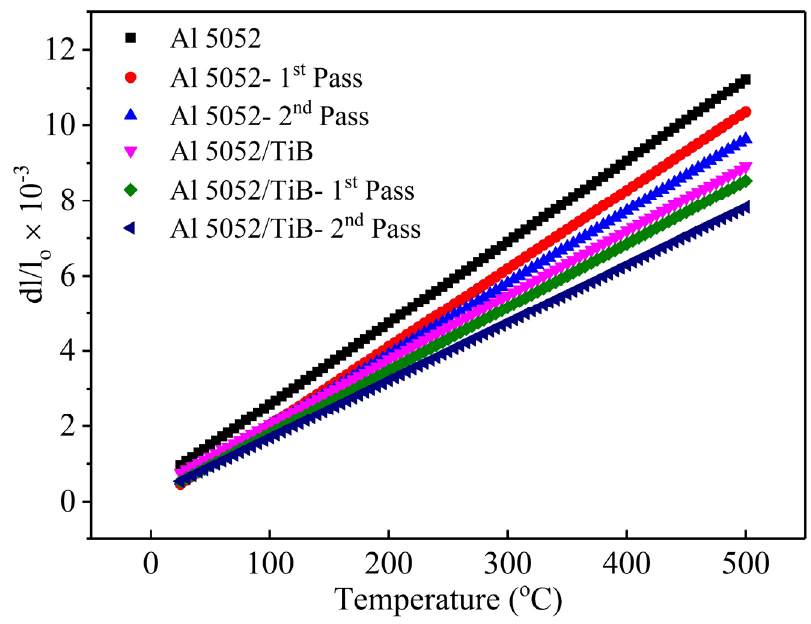
Figure 9. Thermal expansion behavior of the samples. The measured coefficient of thermal expansion (CTE) values for the same samples are shown in Figure 10. The CTE value showed the same trend for ∆ L/L, where there was a slight decrease after FSP for the base alloy, while it decreased significantly with the addition of Ti–B (Al 5052/TiB samples). The CTE value for Al 5052 and Al 5052/TiB was 21.6 and 17.2, respectively. After one pass, the values were 20.8 and 16.8, respectively. However, after two passes, the values were 19.1 and 15.3, respectively. The results indicate that the CTE values showed the same trend of thermal expansion as the CTE value of the base alloy, which slightly decreased after FSP due to the formation of the Mg 2 Si and Al 3 Fe phases, which are characterized by a lower CTE compared to the Al 5052 alloy.